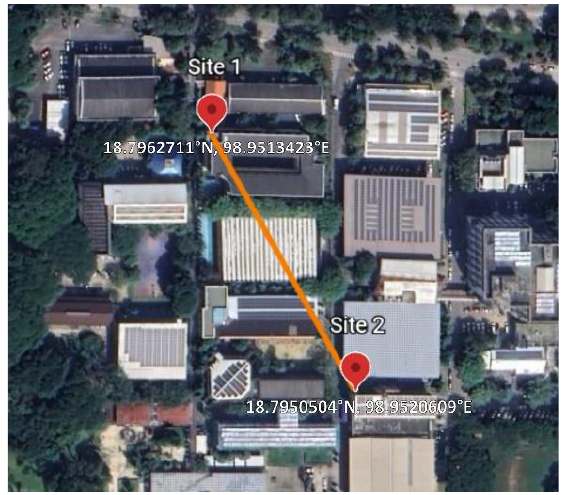
Figure 2. The map of experimental locations with their GPS coordinates.